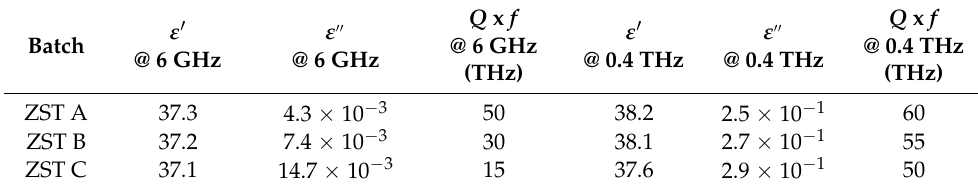
Table 2. Real part ( ε (cid:48) ) and imaginary part ( ε (cid:48)(cid:48) ) of the complex relative permittivity and Q × f product of ZST ceramics measured in microwave (@ 6 GHz) and terahertz (@ 0.4 THz)